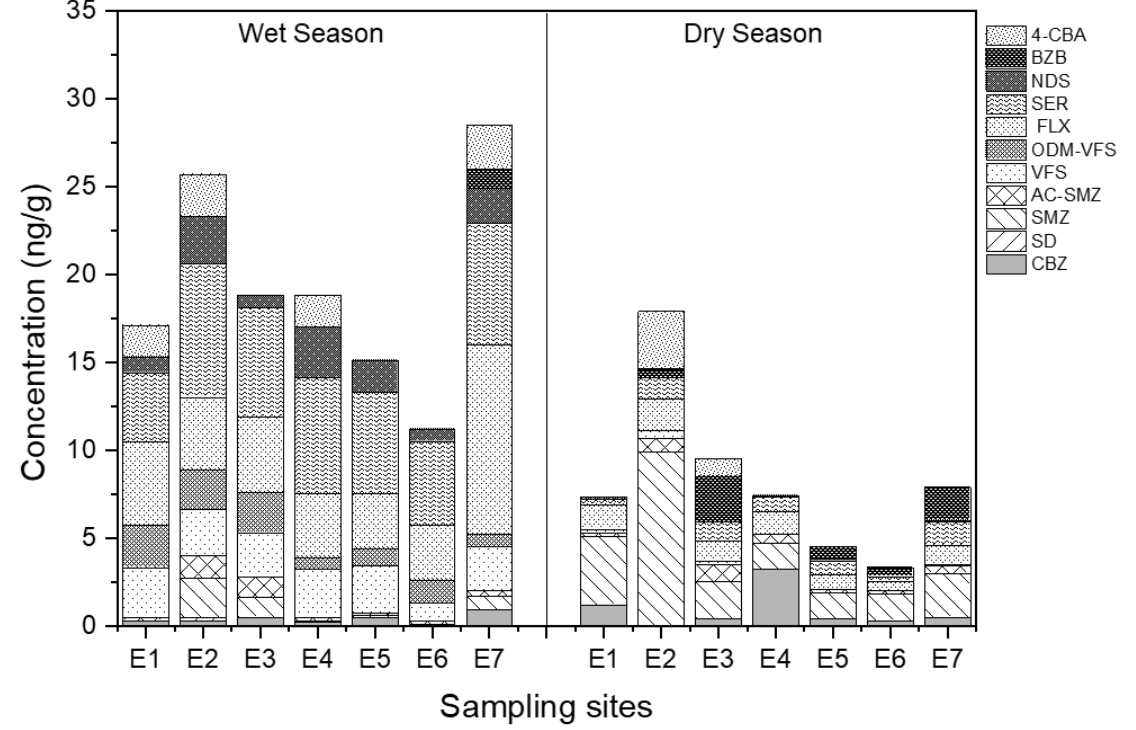
Figure 7. The spatial distribution of pharmaceutical metabolites and their parents in the sediment of the Yunliang river in different seasons.